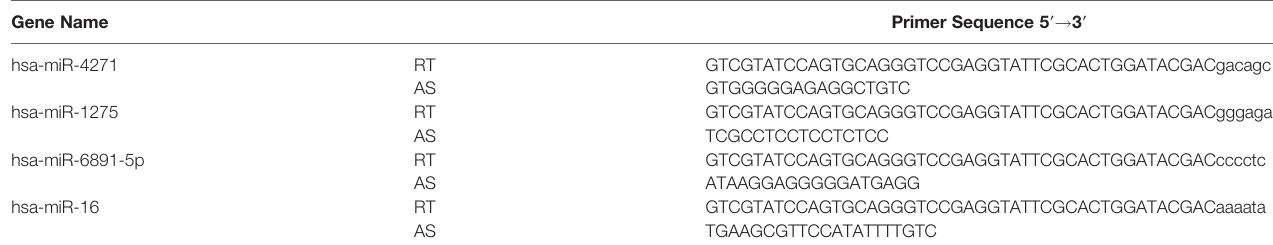
Primers used in this